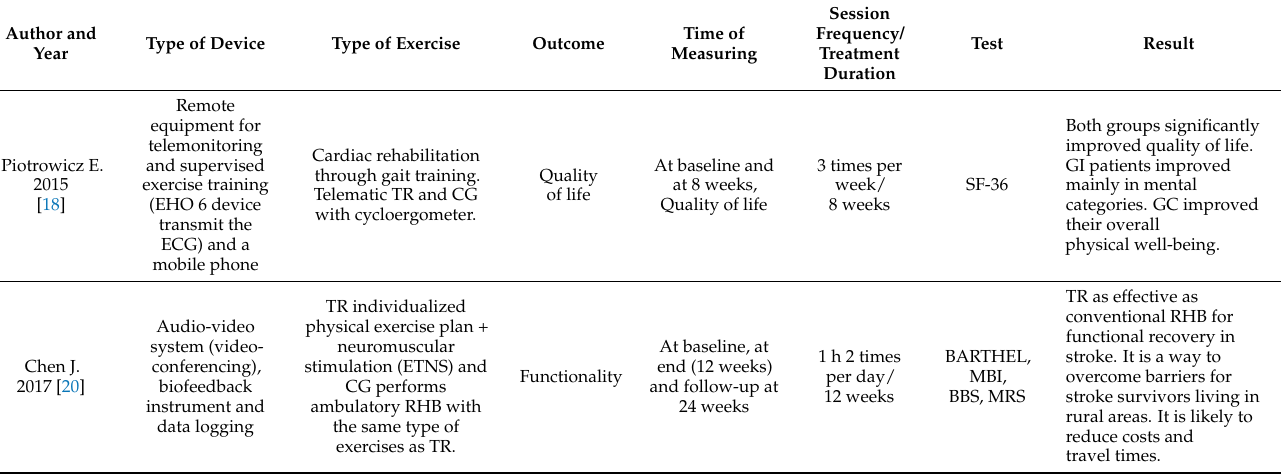
Table 5. Characteristics of telerehabilitation devices, time of measuring, outcome and